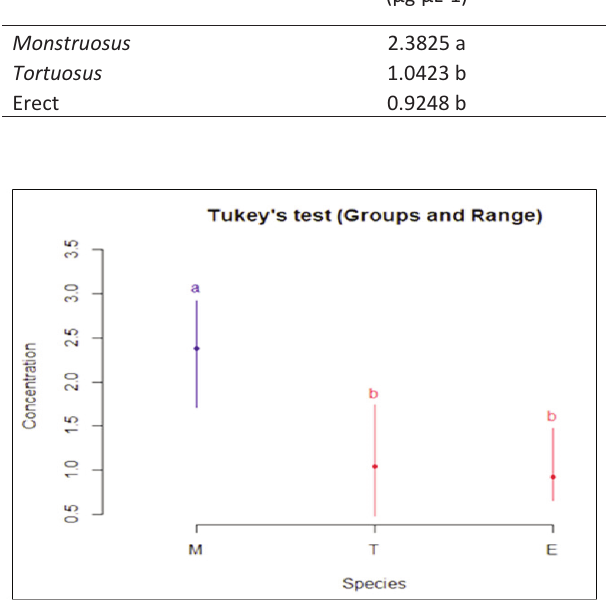
Fig. 2 ­ Amplitude of the concentration values observed within monstruosus (M), tortuosus (T), and erect (E) plants of Cereus